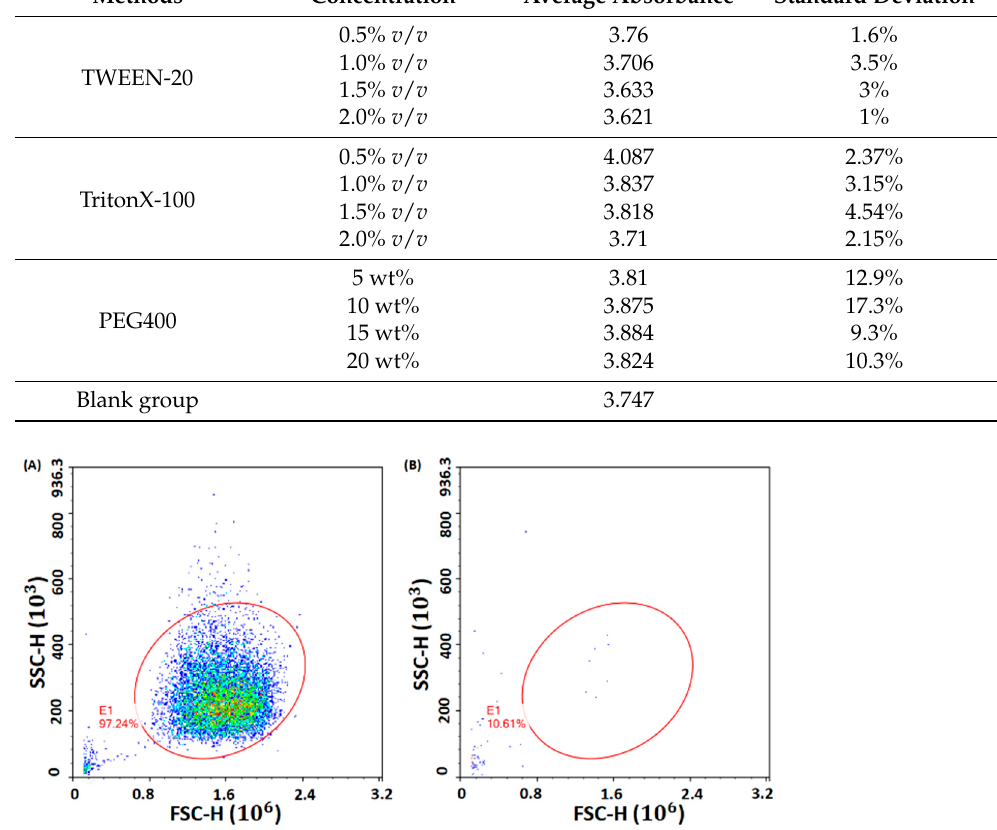
Figure 8. Number of RBCs calculated by flow cytometry: ( A ) before separation; ( B ) after separa-